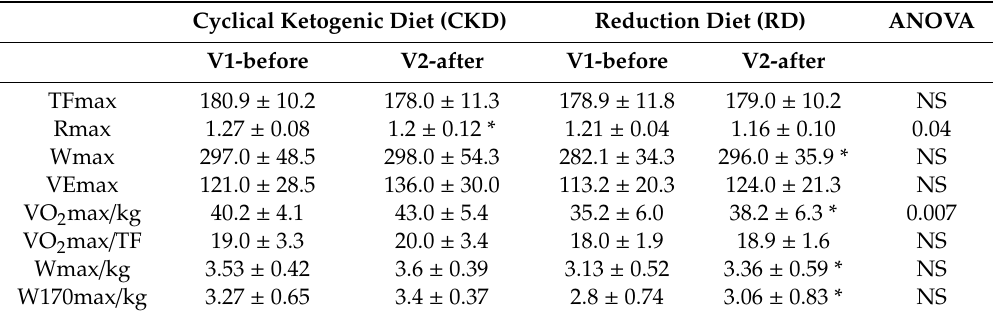
Table 3. The e ff ect of cyclical ketogenic reduction diet and nutritionally balanced reduction diet on aerobic performance